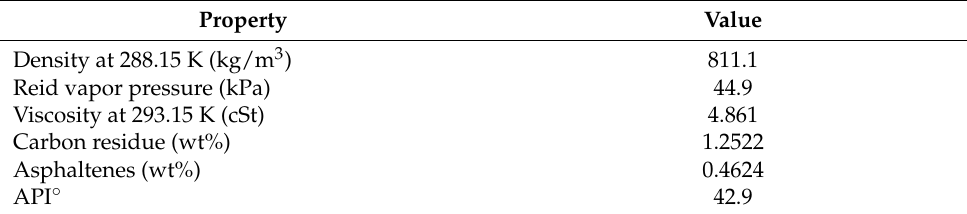
Table 1. Properties of crude oil (provided by